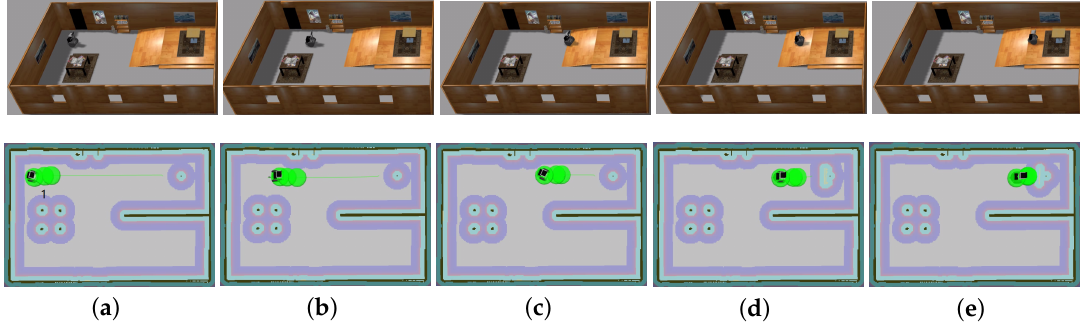
Figure 8. Simulation experiment of Task 1. The start location is indicated in ( a ). The robot is approaching the slope in ( b , c ). The robot starts to climb the slope in ( d ) and reaches the target above the ground in ( e